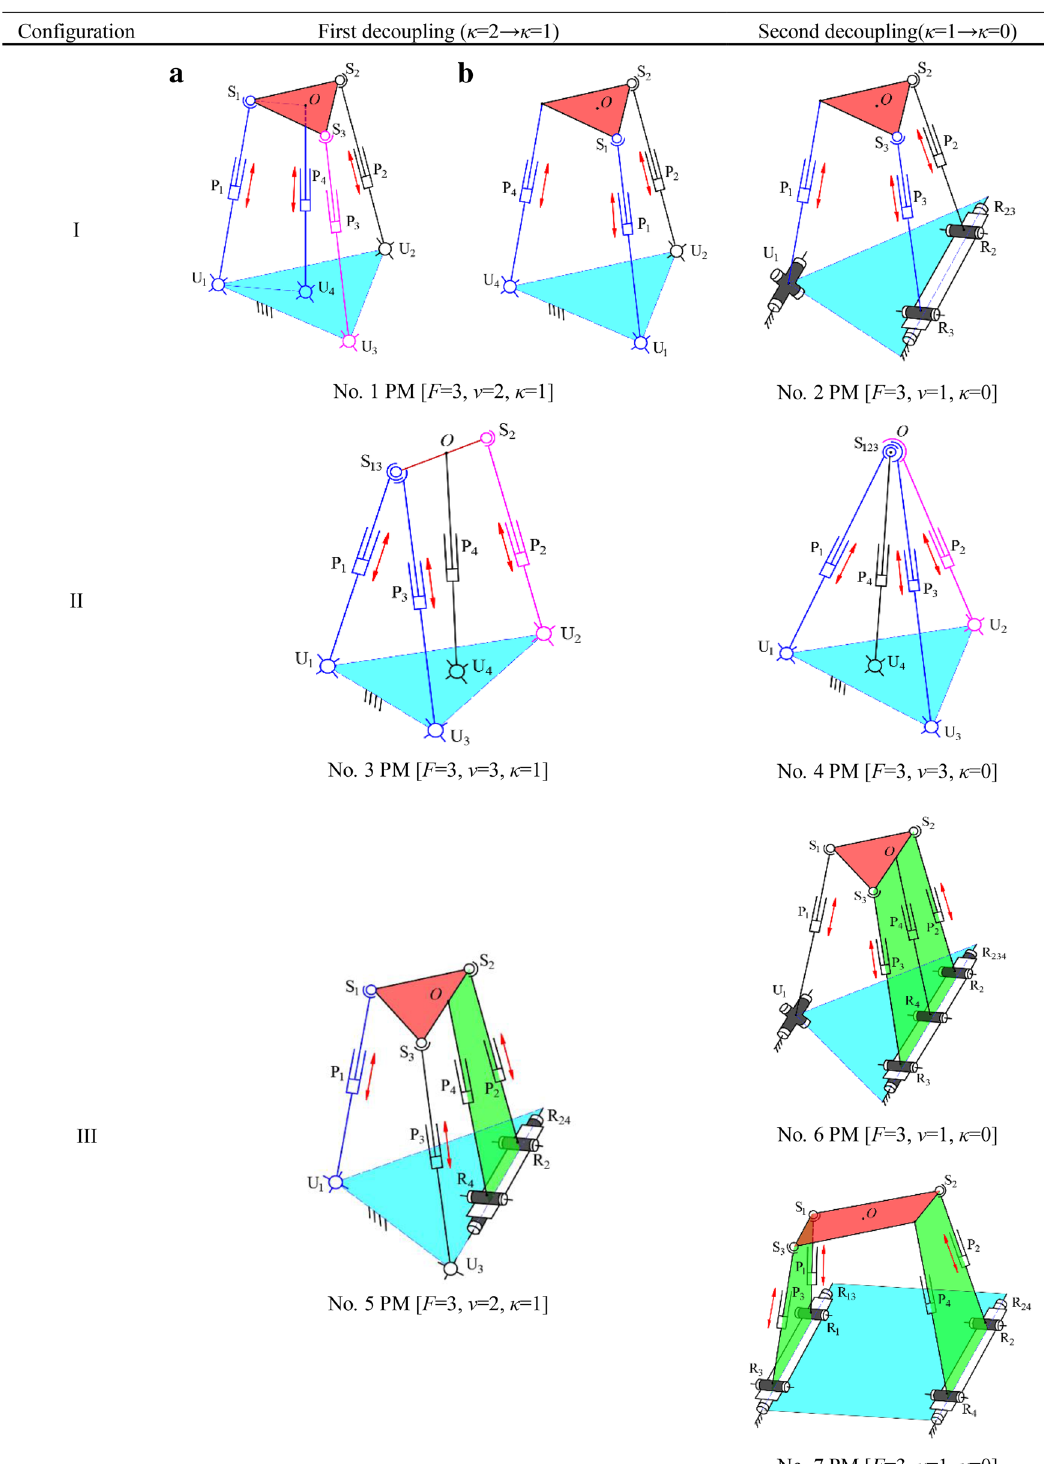
Table 1 Topological structure obtained via design of SCR for